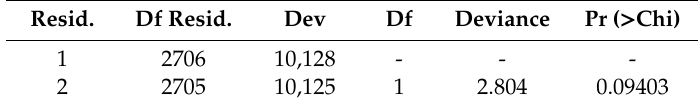
Table 27. Comparison of the variables contrast ratio and device used by